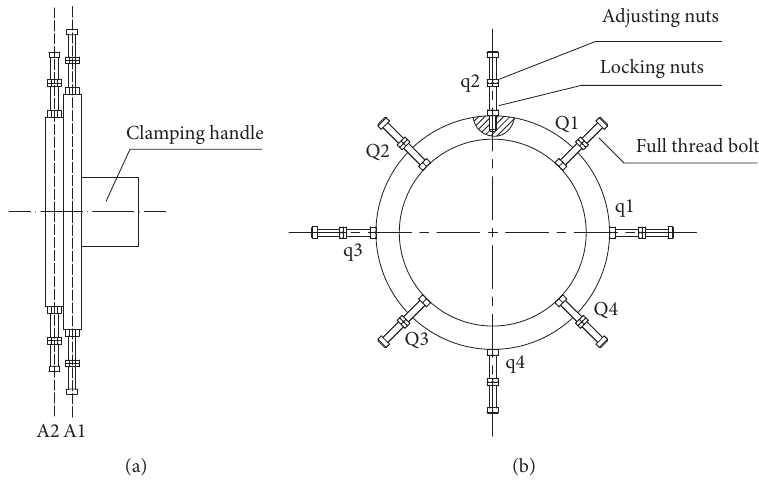
Figure 5: The structure of experimental workpiece: (a) the main view of workpiece; (b) the left view of